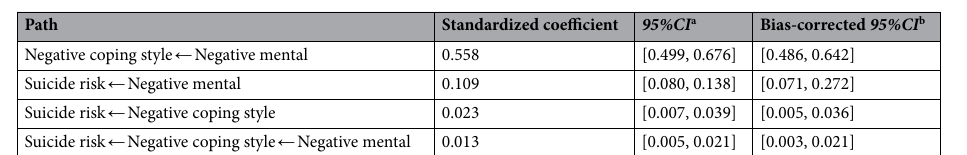
Table 3. Path effects of negative mental, negative coping style and suicide risk. a 95% confidence interval calculated for the percentile method; b 95% confidence interval calculated for bootsrap